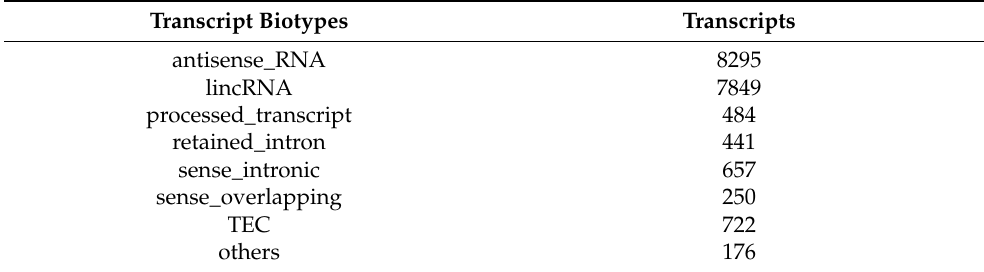
Table 2. Overall statistics of known lncRNAs. Transcripts’ biotypes were classified according to the ENSEMBL